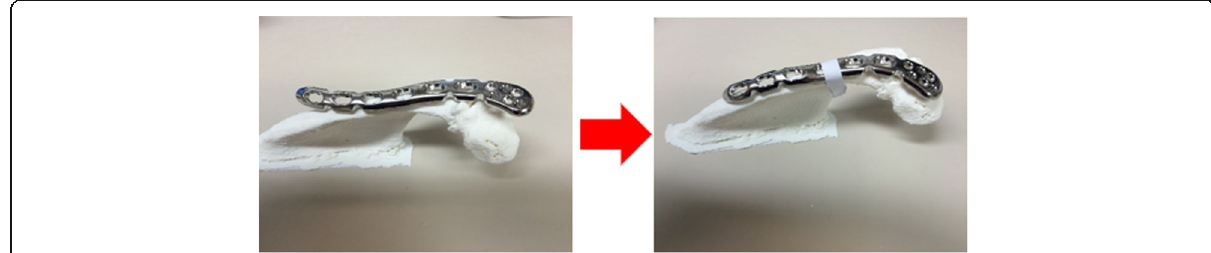
Fig. 2 Bending the osteosynthesis plate based on the 3D print. A correction was made to lift the anterior acromion and to prevent further impingement on the rotator cuff